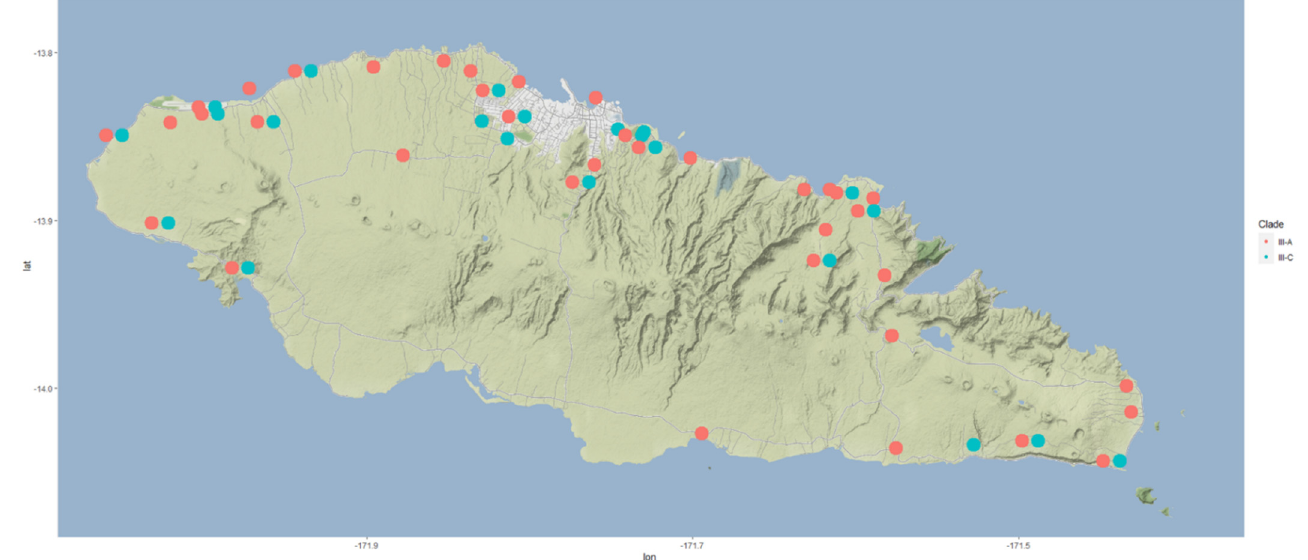
Figure 5. Distribution of assigned subclades from CRB ( Oryctes rhinoceros ) samples collected from the pheromone trap network in Upolu, Samoa. Color indicates different variants within clade III as per Marshall et al., 2017, with III-A (red dots) indicating specimens identical to the Samoa A15 reference sequence, while III-C (blue dots) specimens were identical to the Samoa A35 reference sequence. Longitude values are shown on the x -axis and the latitude values on the y -axis.